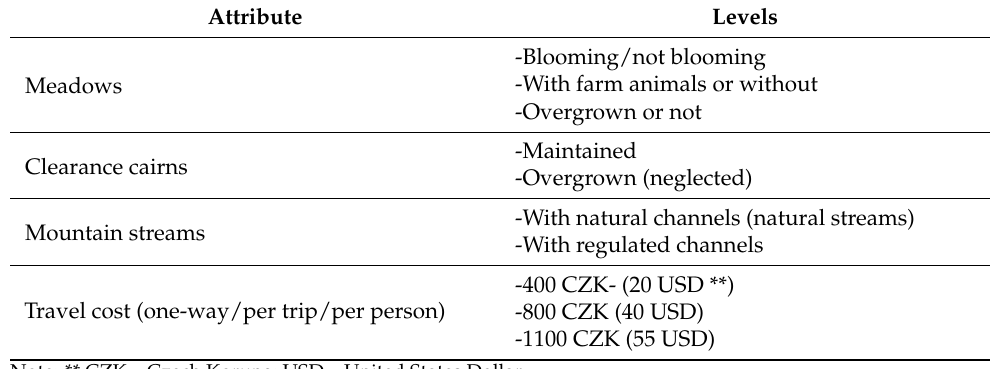
Table 2. Choice experiment attributes and levels (source: authors).